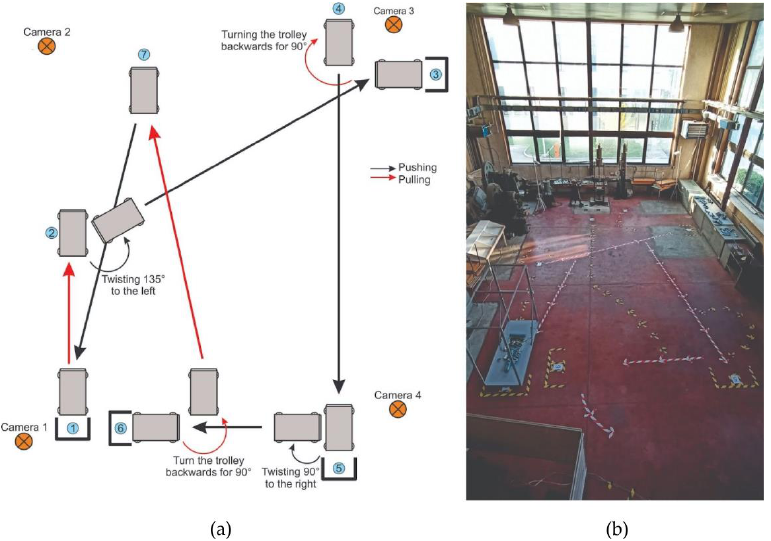
Figure 3. Considered P&P tasks and experimental environment. ( a ) P&P path sketch and ( b ) Work- place polygon. ( b ) Workplace